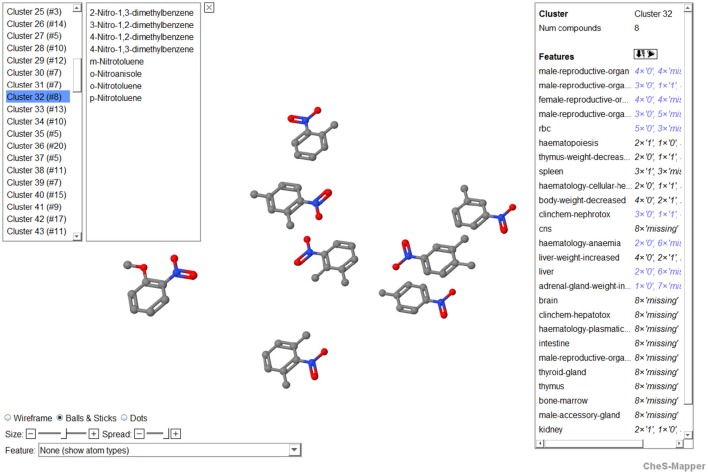
Screenshot of CheS-Mapper showing cluster 32 that includes eight compounds (nitrotoluenes and dimethylnitrobenzenes). In the upper left corner, all clusters are listed and the members of the selected cluster 32 are shown. On the right side of the application screen, the user can select features for which the frequencies are depicted, in this example the frequencies of the discretized organ-effect combinations (0, low potency; 1, high potency, missing) are displayed. In the lower left corner of the screen, features are given to change and adopt the molecular visualization.